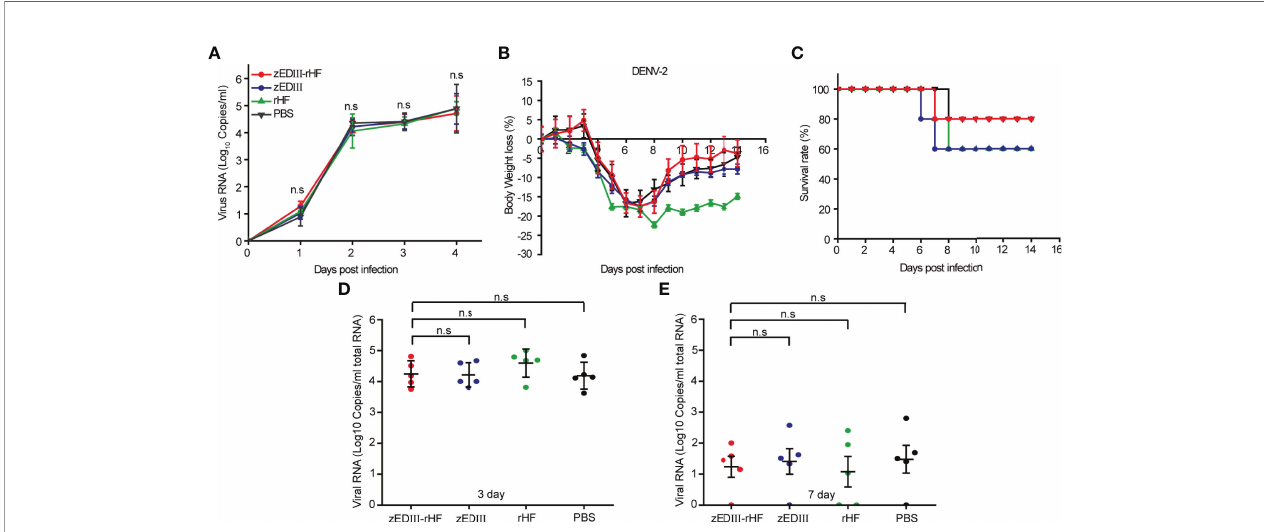
FIGURE 6 | Analysis of ADE activity for DENV-2 infection after zEDIII-rHF vaccination. (A) Viral RNA titers in THP-1 cells incubated with DENV-2 TSV-01 mixed with mouse serum. (B) Body weight changes of mice after infection with DENV-2. (C) Survival rates of mice postinfection, n = 5. (D) DENV-2 RNA titers in mouse sera on day 3 postinfection, n = 5. (E) DENV-2 RNA titers in mouse sera on day 7 postinfection, n = 5.The data in 6a, 6d, 6e are shown as the mean and standard deviation (mean ± SD) analyzed by Student ’ s t-test; *P < 0.05, **P < 0.01 . ns, no signi fi cant